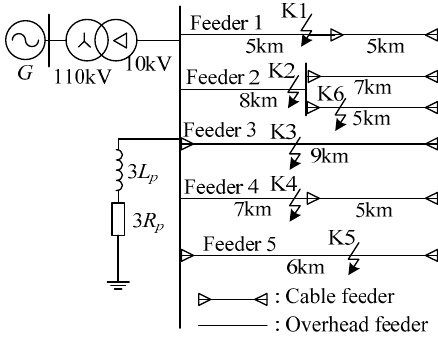
Figure 2. Simulation model for the single-phase HIF in RGDS.